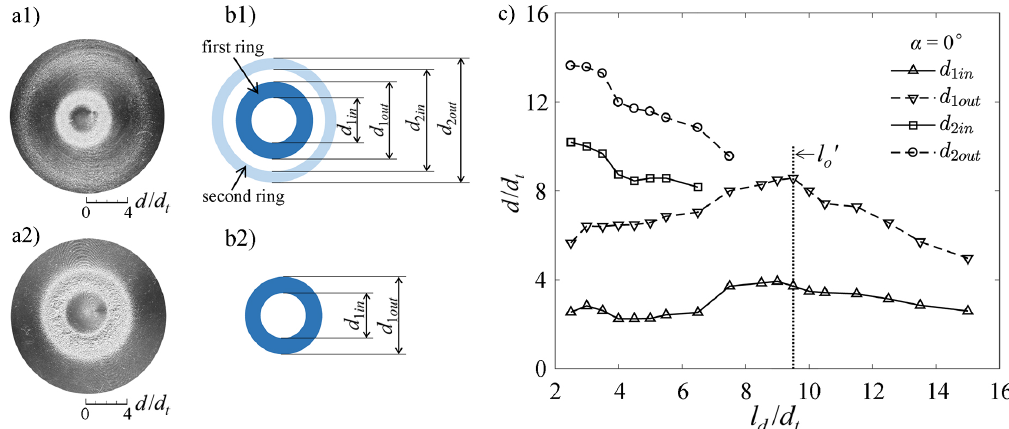
Figure 4. Normal view of eroded surface at α = 0 ◦ : ( a1 ) l d / d t = 3.5, ( a2 ) l d / d t = 9.5, ( b1 , b2 ) schematics of erosion area, ( c ) erosion distribution.